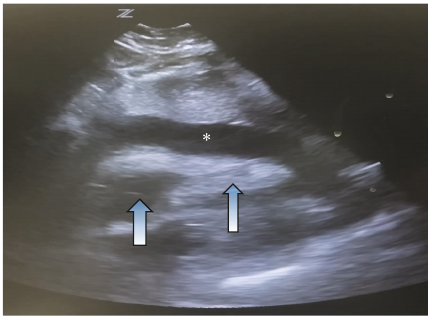
Figure 2: Subxiphoid window on bedside echocardiography demonstrating a large pericardial effusion (indicated by the ∗ ) associated with right ventricular (RV) and right atrial (RA) collapse (indicated by the